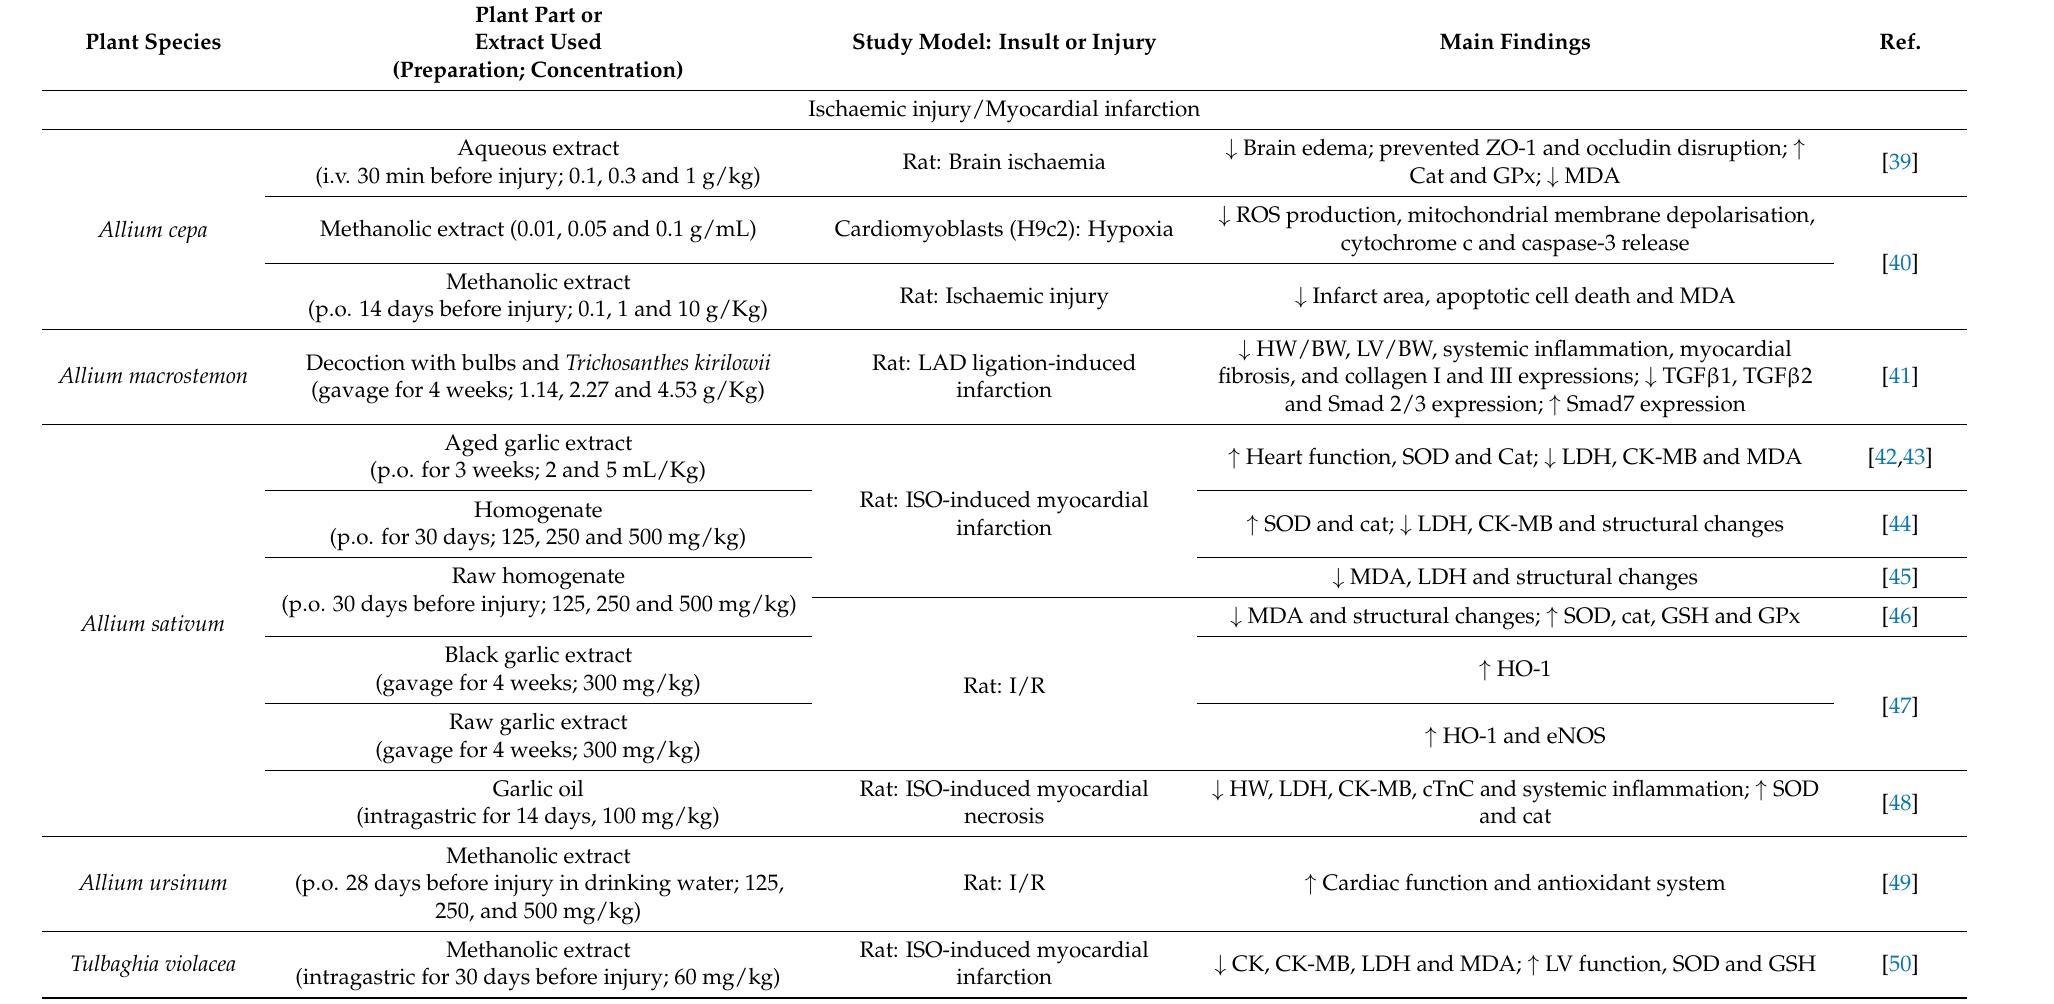
Table 2. Effects of plant parts/extracts from the Allioideae on the cardiovascular